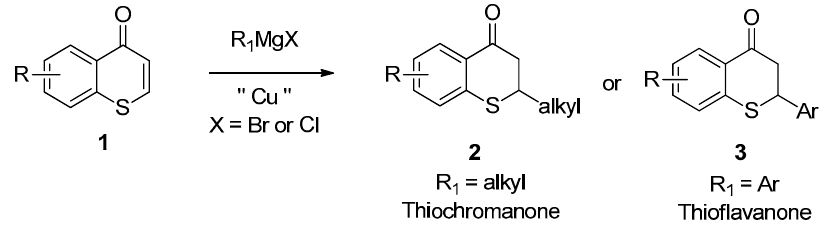
Figure 1. Copper-catalyzed conjugate addition of Grignard reagents to thiochromones.